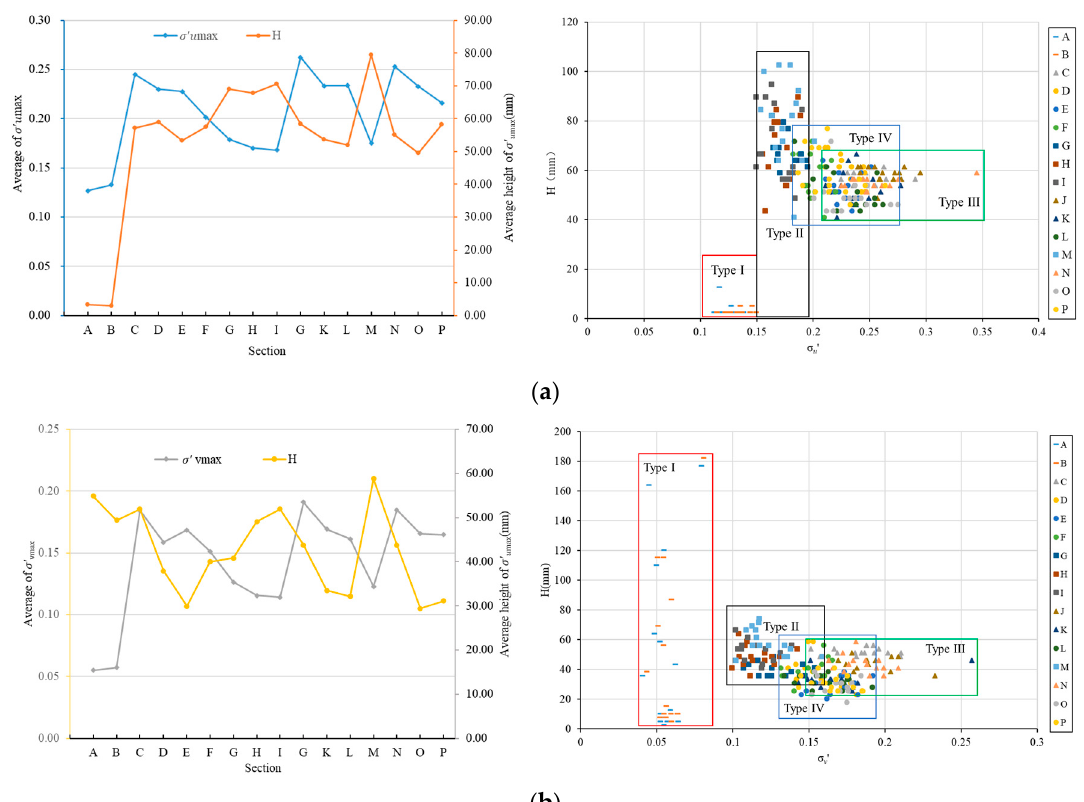
Figure 12. Distribution of maximum turbulence intensity for each typical section in the artificial reef area. ( a ) The location of the maximum value of the longitudinal turbulence intensity; ( b ) the location of the maximum value of the vertical turbulence intensity.